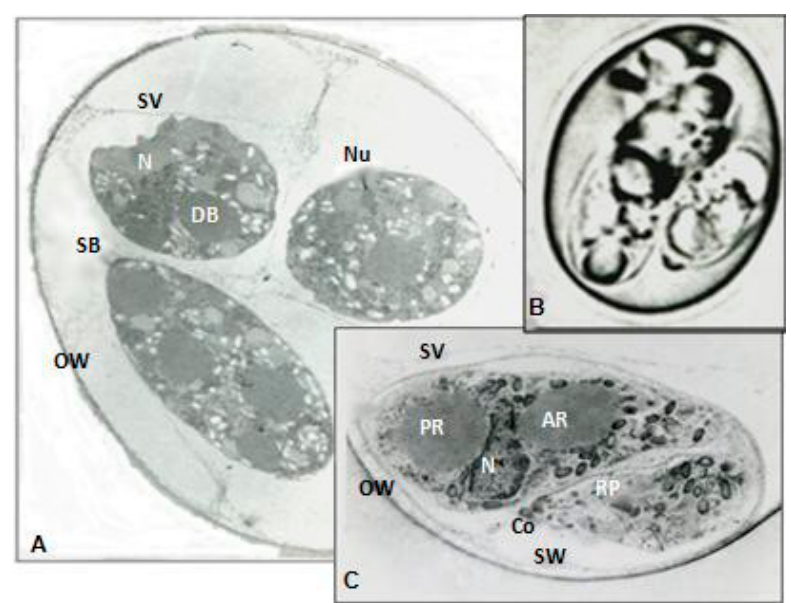
Figure 1. ( A , C ) Transmission electron micrographs (TEM) from mature ( A , C ) and light micrograph ( B ) from normal organism representative ( E. tenella ). ( A ) Mature normal organism (oocyst) representative 34 h of developmental stage (sporulation) demonstrating 3 of 4 sporocysts, oocyst wall (OW), Stieda body (SB), sporocysts wall (SW), sporocysts veil (SV) dividing the organism into a honey-combed chamber, nucleolus (Nu) ×7000. ( B ) A normal organism under light microscopy with 3 of 4 sporocysts ×800. ( C ) Enlarged micrograph from mature sporocyst contains 2 mature sporozoites within the sporocyst’s wall 34 h of developmental stage. Each sporozoite contains refractile bodies ×13,000. Note Nucleus (N), Dense body (DB), Anterior (AR) and posterior refractile bodies (PR), Rhoptry (Rh), nucleolus (Nu), Sprocyst veil (SW), Oocyst wall (OW).